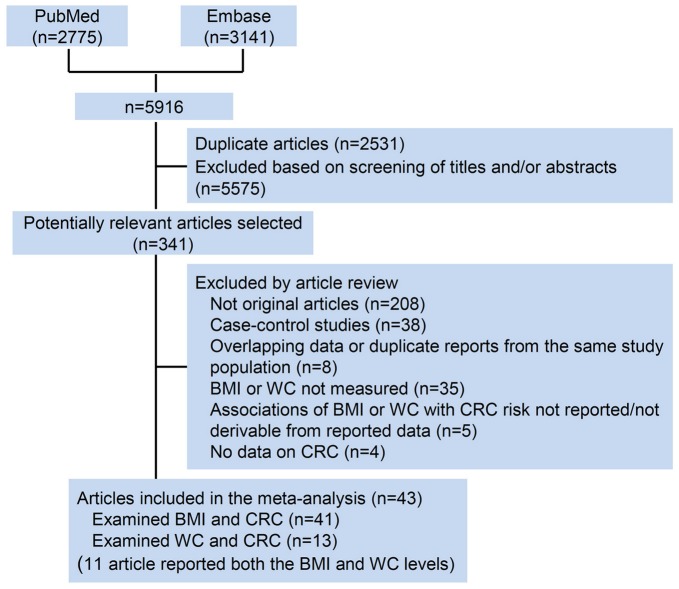
Flow diagram of the literature search process.CRC, colorectal cancer; BMI, body mass index; WC, waist circumference.